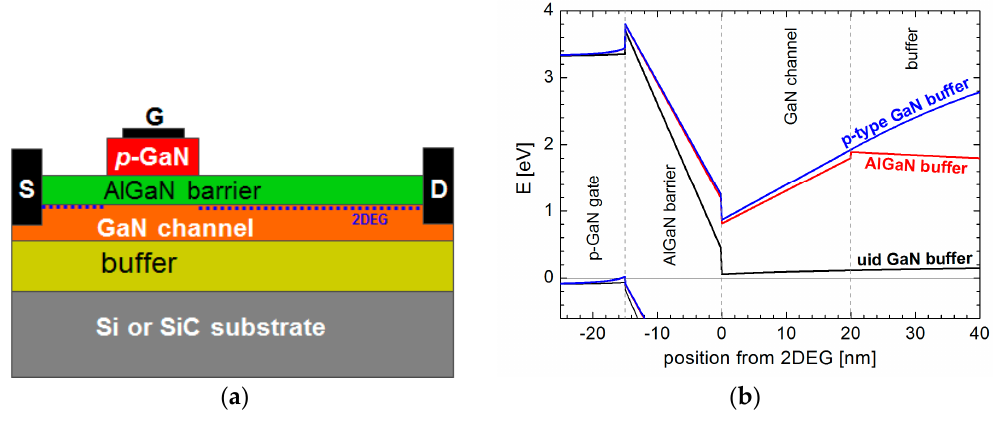
Figure 3. Normally-off GaN transistors utilizing charge management in gate region: ( a ) GaN normally-off transistors using p-type doped GaN underneath the gate metal; and ( b ) Energy band diagram of a p-GaN type normally-off transistor comparing AlGaN buffer and p-type (compensation-doped) GaN buffer versus an unintentionally doped (uid) GaN buffer.